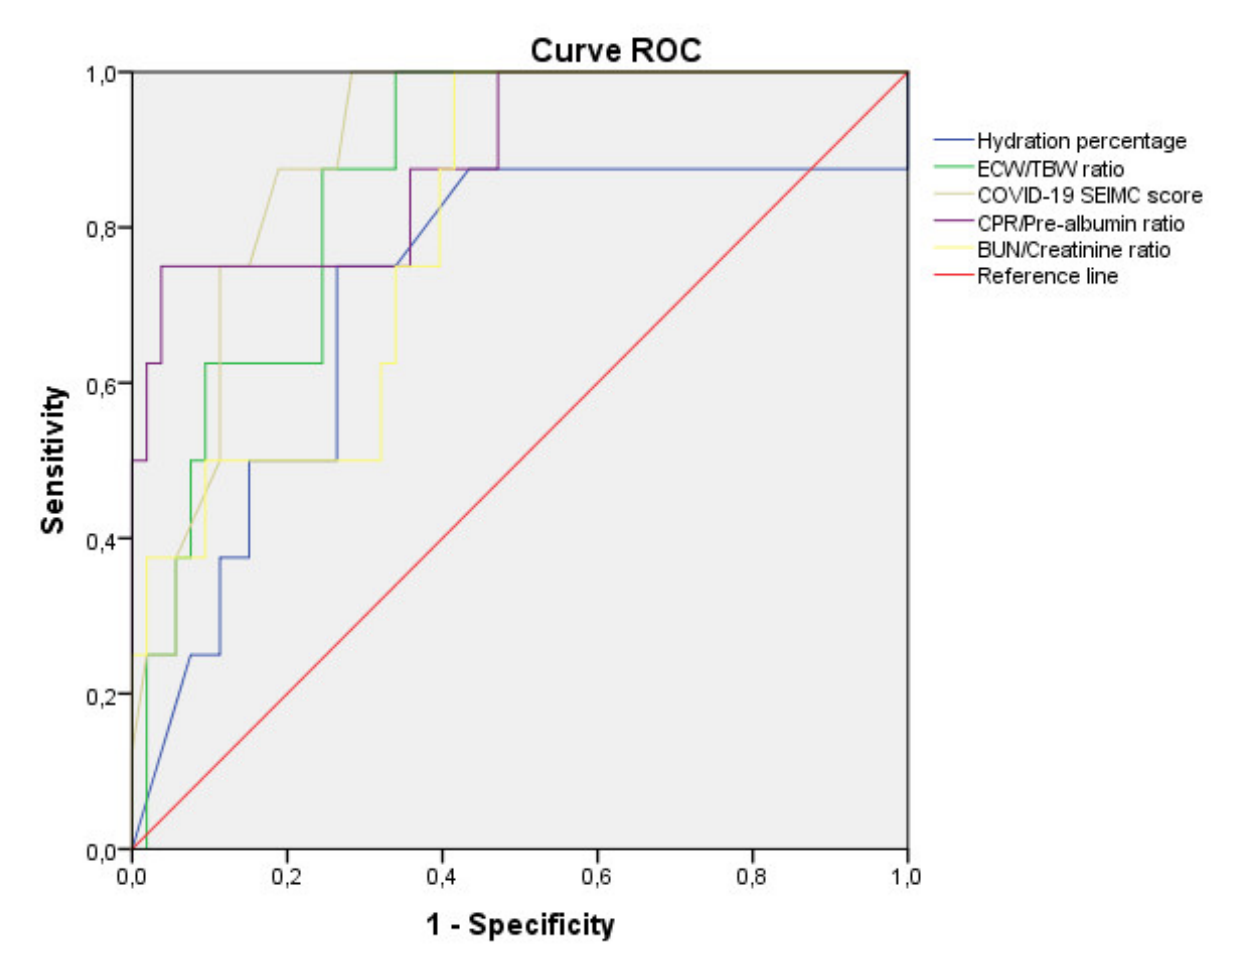
Figure 3. Comparative analysis of ROC curve of hydration with established prognosis factor in COVID-19 patients. Comparative analysis of the receiver operating characteristic curves of hydration percentage, ECW/TBW ratio, COVID-19 SEIMC clinical score, and analytical indicators (CRP/pre-albumin, BUN /creatinine) for prediction of mortality in patients with COVID-19 ( n = 127). Table 3. Analysis of the prognostic factors of mortality in COVID19 SEIMC score greater than 10.5 points, CRP/pre-albumin greater than 0.88,